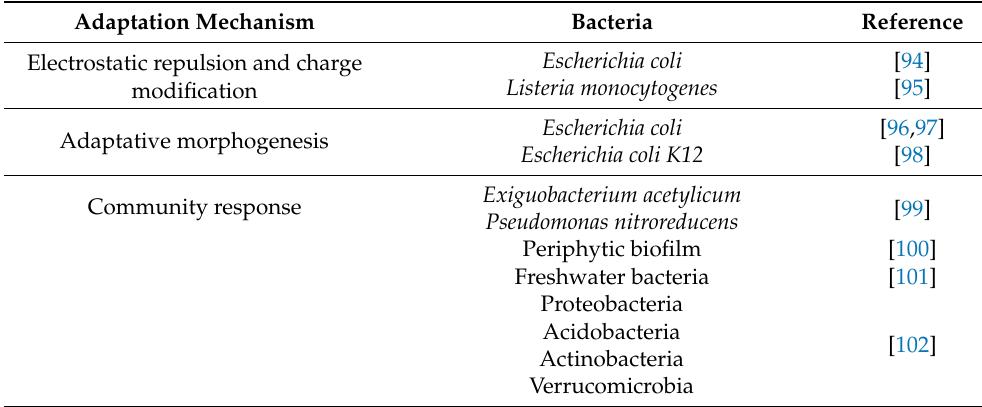
Table 2. TiO 2 NP bacteria